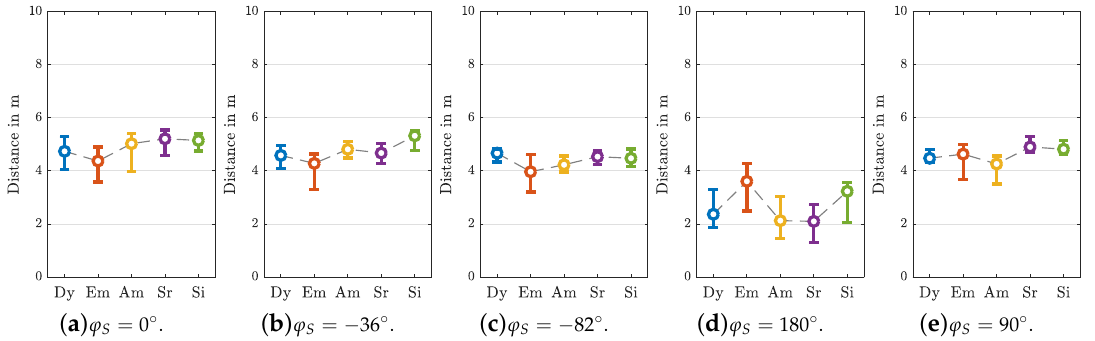
Figure 10. Median value and 95% confidence interval of distance ratings per beam direction ϕ S . Please note the fixed y-axis showing the interval of [ 0,10 ] m form the listener.